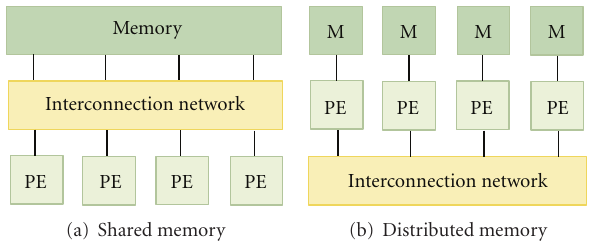
Figure 1: Shared x distributed